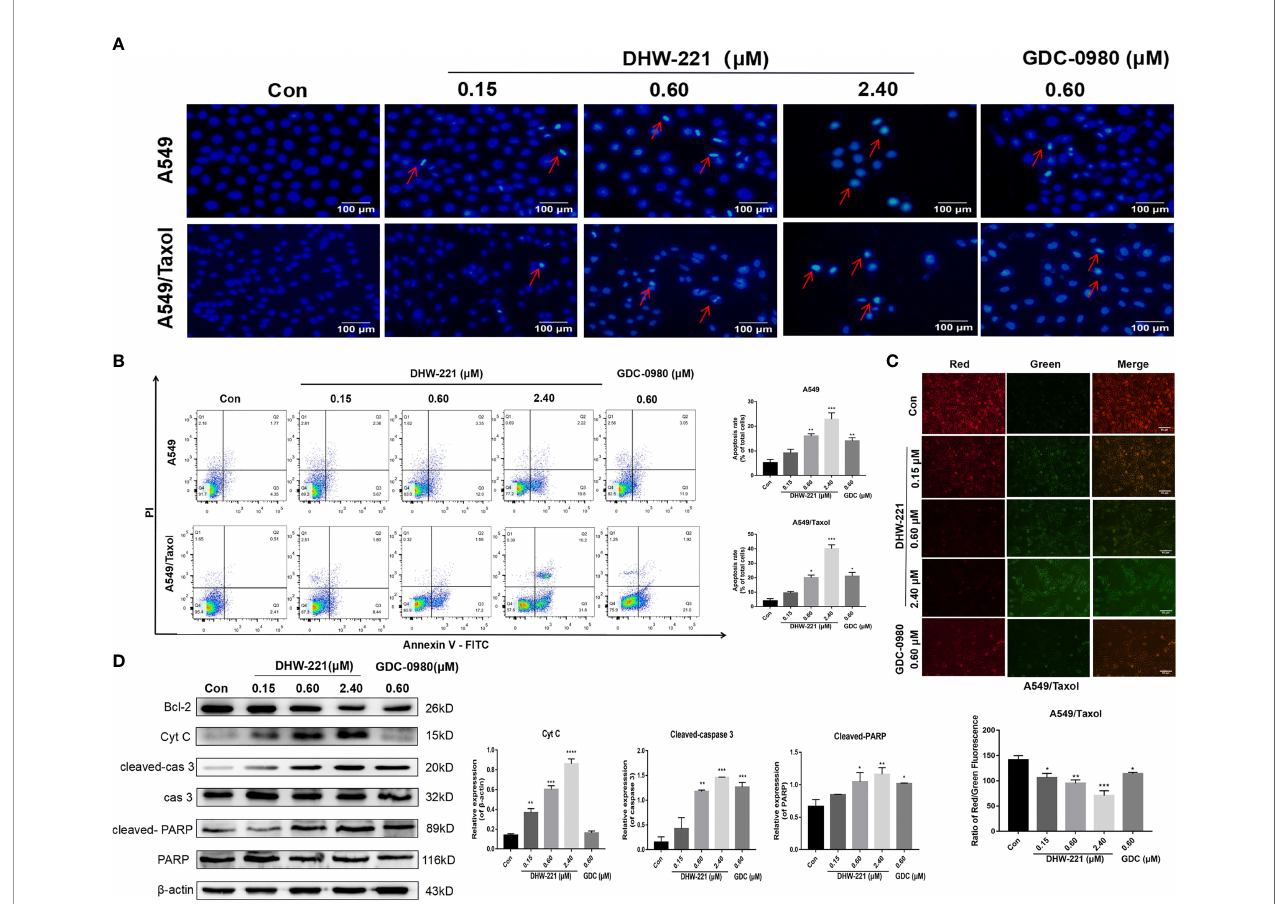
FIGURE 3 | DHW-221 exerts an evident pro-apoptotic effect through the mitochondrial pathway in A549/Taxol cells. (A) Hoechst 33342 staining results for 48 h in A549 and A549/Taxol cells. Strong blue fl uorescence indicated apoptotic cells, scale bar = 100 µm. (B) Induction of apoptosis by various concentrations of DHW-221 in A549 and A549/Taxol cells were evaluated by Annexin-V-FITC/PI staining for 48 h. (C) The changes of mitochondrial membrane potential in A549/Taxol cells were detected by JC-1 staining after exposure to DHW-221 and GDC-0980. Green and red fl uorescence represented decreased and normal mitochondrial membrane potential, respectively. Scale bar = 100 µm. The red and green mean fl uorescence intensity were measured by ImageJ software, and the relative radio was analyzed using GraphPad Prism 7.0 software. Statistical comparisons were performed with one-way ANOVA followed by Dunnett ’ s post-hoc test for multiple comparisons (n = 3). *p < 0.05, **p < 0.01, ***p < 0.001 versus control. (D) Western blot analysis of apoptosis-related proteins in A549/Taxol cells. Cells were treated with various concentrations of DHW-221 (0.15, 0.60, and 2.40 µM) and GDC-0980 (0.60 µM) for 48 h. Statistical comparisons were performed with one-way ANOVA followed by Dunnett ’ s post-hoc test for multiple comparisons (n = 3). Data were expressed as mean ± SD. *p < 0.05, **p < 0.01, ***p < 0.001, ****p < 0.0001 versus